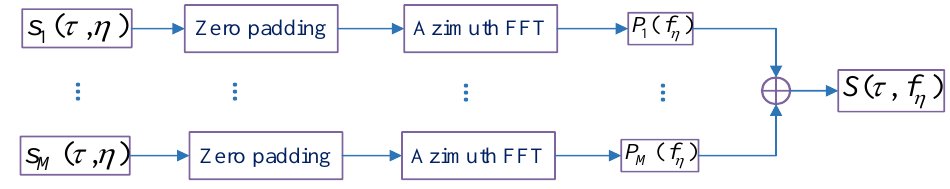
Figure 4. The flowchart of the reconstruction.